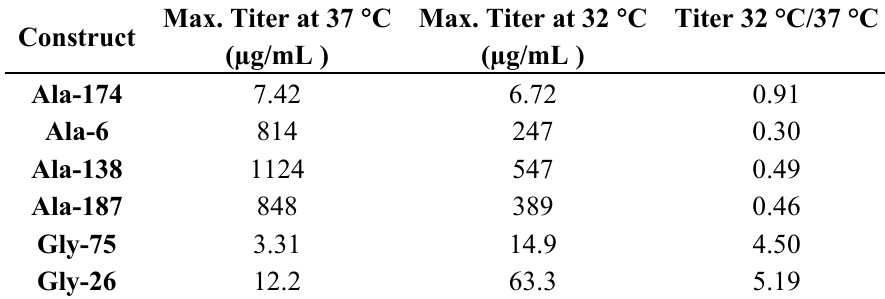
Table 1. Effect of culture temperature on antibody